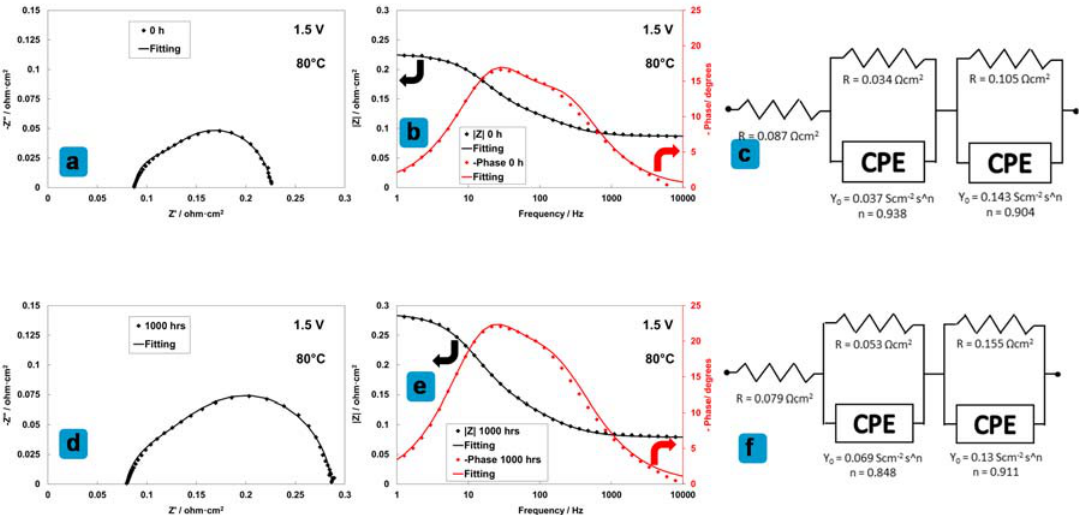
Figure 12. EIS at 1.5 V and 80 °C, before and after a 1000 h durability test at 3 A cm − 2 , for a low-loading MEA (both low anode 0.4 mg cm − 2 and cathode 0.1 mg cm − 2 loadings). Nyquist plots are reported in ( a , d ); Bode plots are reported in ( b , e ); equivalent circuits are reported in ( c , f ).